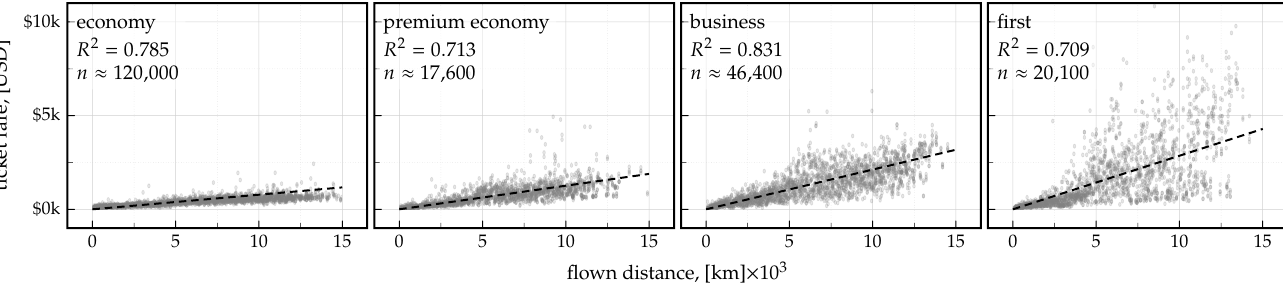
Figure 8. AirLYFE’s default distance dependent ticket price